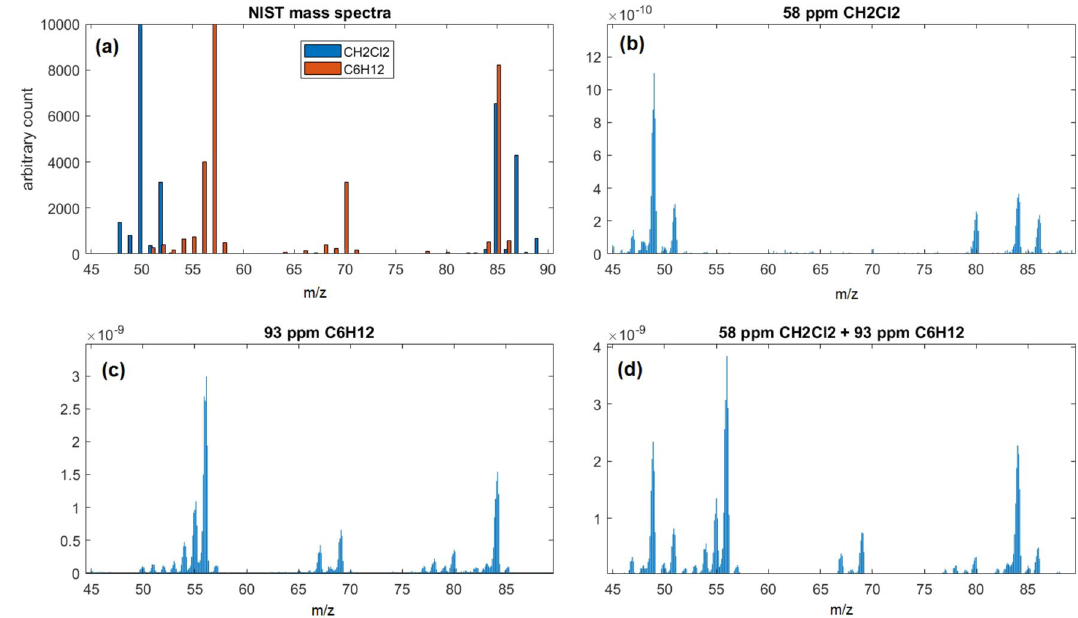
Figure 5. Mass spectra recorded at 45–90 u/e − . Each spectrum acquisition lasts about 60 s. Mass spectrum of